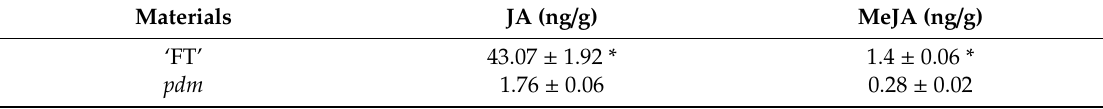
Table 1. JA and MeJA contents in petals of ‘FT’ and pdm